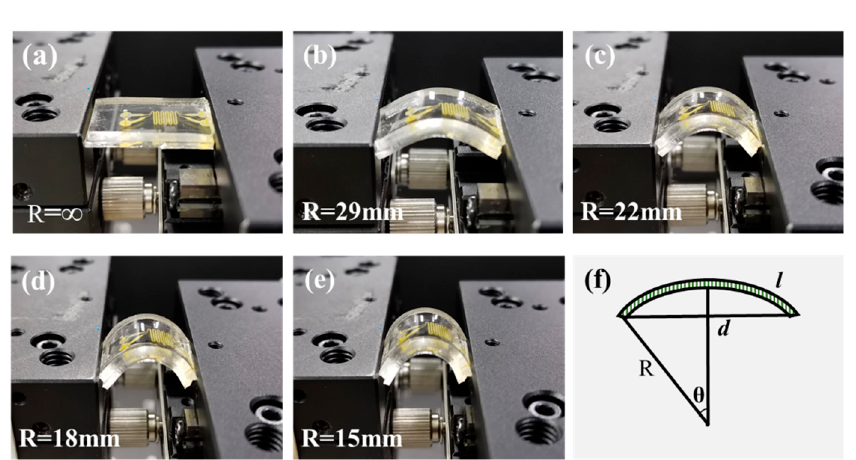
Figure 5. ( a–e ) Flexible chips with different bending radii, and ( f ) the schematic diagram of a bent FQCL. bent